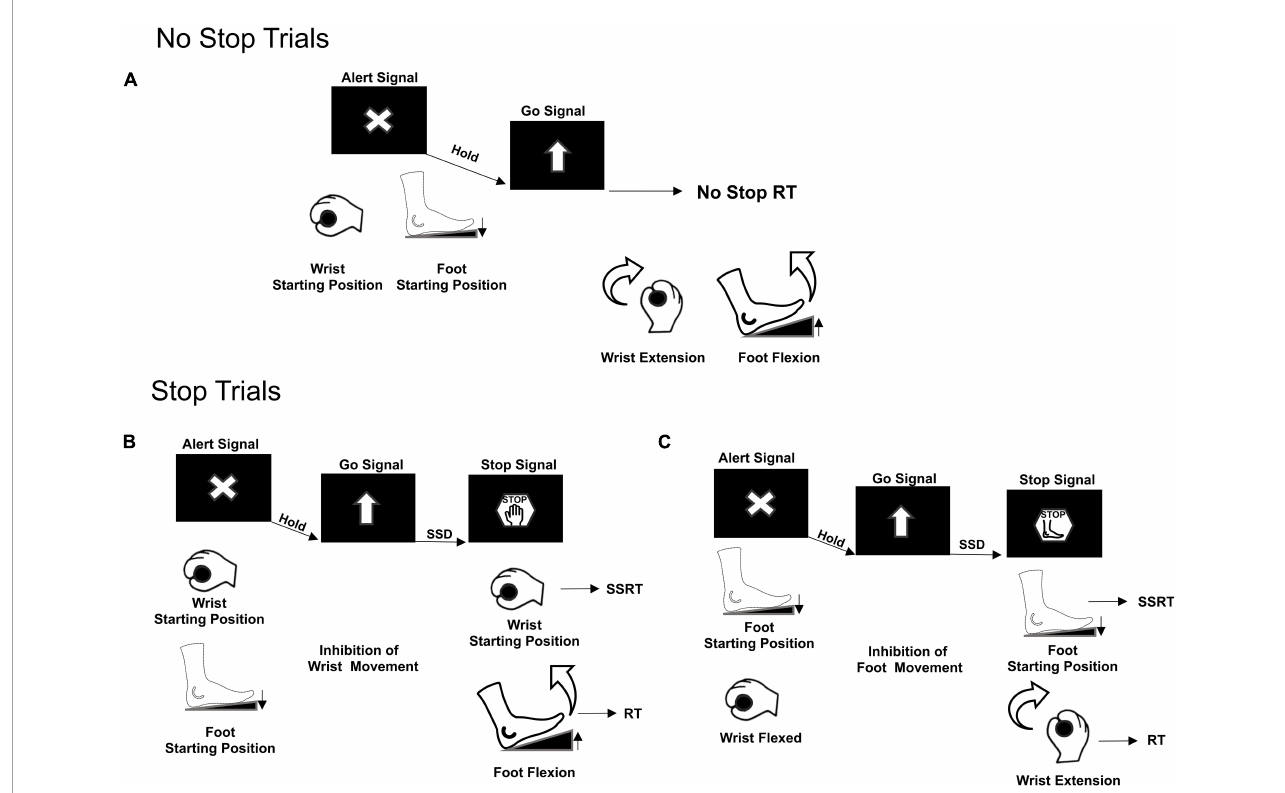
FIGURE1 Multi-Effector selective SST. Two types of trials were presented, No Stop trials (A) and Stop Trials (B,C) . Movement of both effectors, wrist and foot, was required only in No Stop trials. Movement cancelation was required only in Stop trials. Depending on the different Stop versions of the task, the appearance of the Stop Signal informed either to cancel the movement of both effectors, Stop Both not shown, or to selectively cancel either the wrist movement, but still move the foot (B) or the foot movement, but still move the wrist (C) . RT, Reaction Time; SSD, Stop Signal Delay; SSRT, Stop Signal Reaction